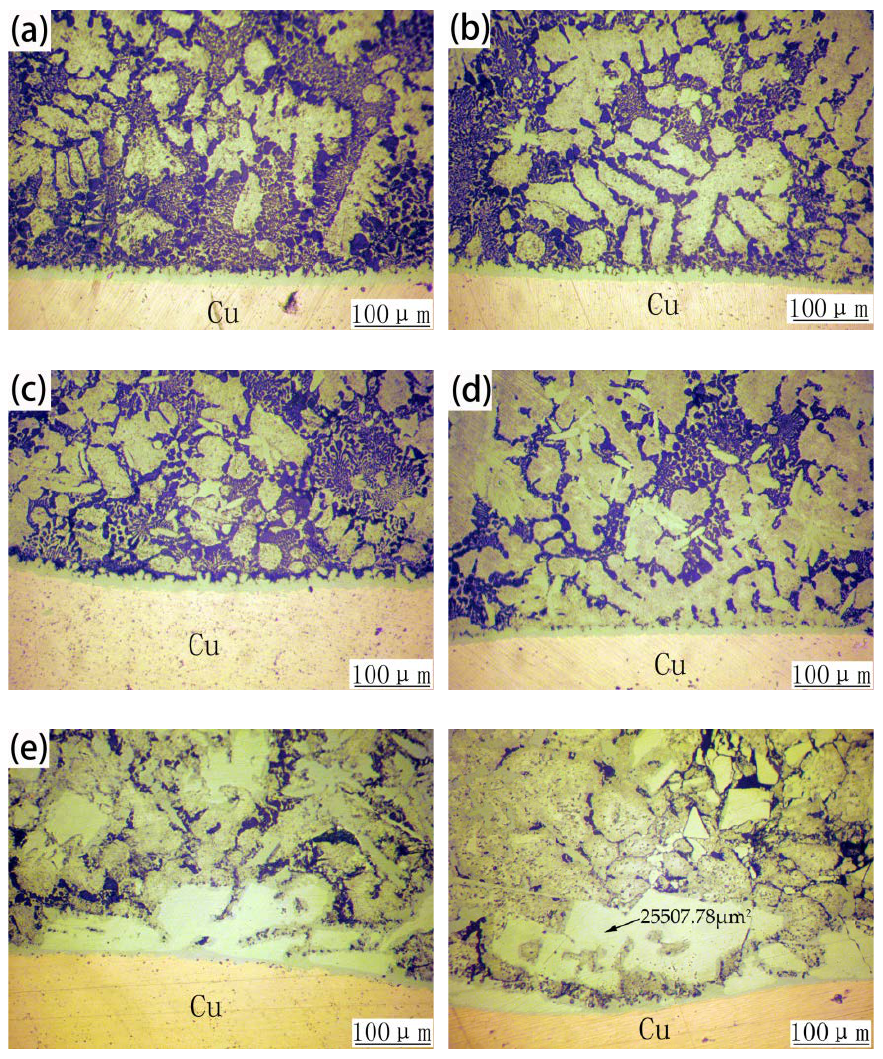
Figure 13. Microstructures of brazing seam/Cu interfaces of 1035 Al/Cu joints brazed by ( a ) Zn-2Al; ( b ) Zn-5Al; ( c ) Zn-12Al; ( d ) Zn-15Al; ( e ) Zn-20Al; and ( f ) Zn-25Al. Crystals 2020 , 10 , x FOR PEER REVIEW 12 of 16